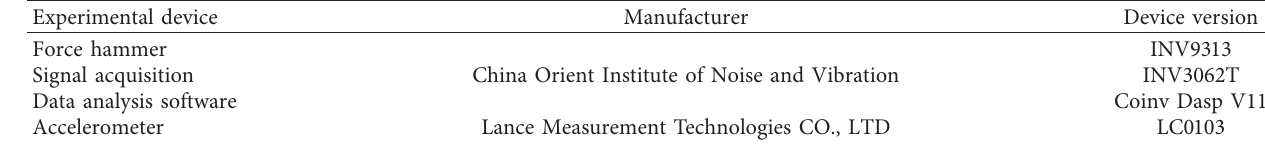
Table 3: Beam parameters and number.